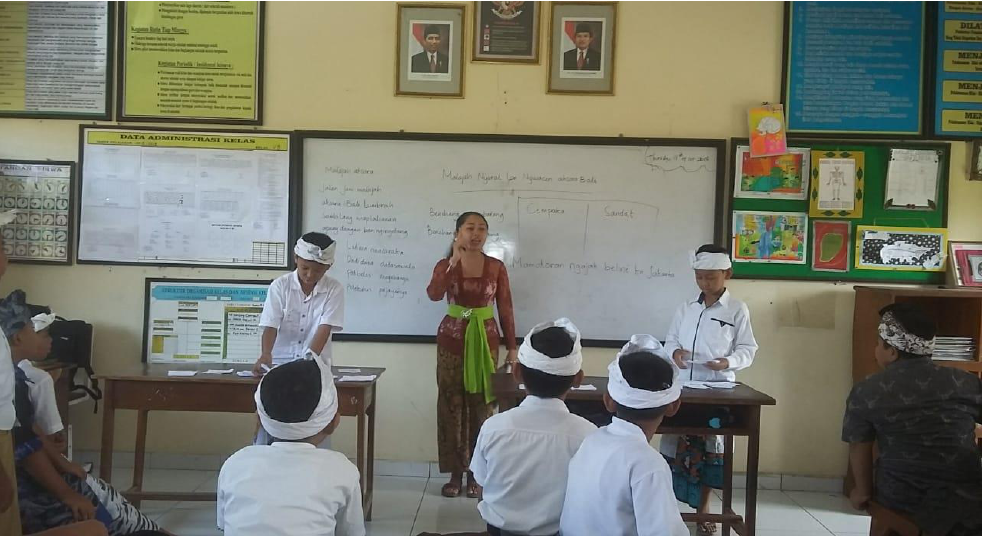
Figure 4. Learning at SDN 17 Dauh Puri